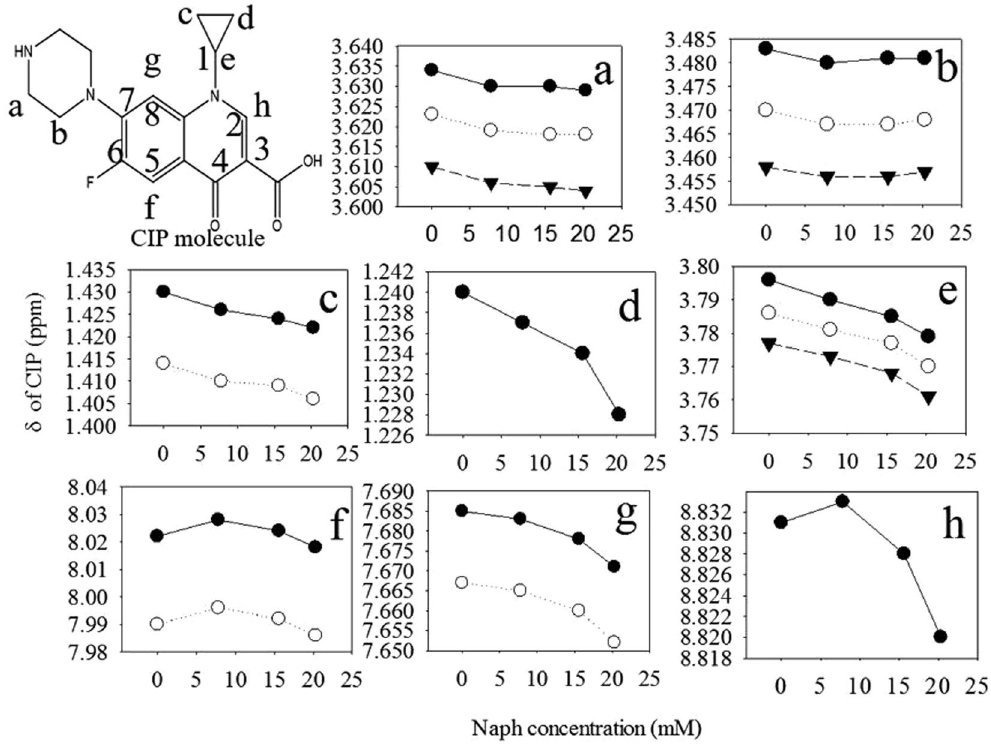
Figure 4. 1 H NMR chemical shift of CIP as π -acceptors in methanol- d 4 affected by complexation with Naph as π -donors. CIP concentration was 7.8 mM, and Naph concentration was 0, 7.8, 15.6 and 20.3 mM. ( a–h ) were noted as H position in CIP